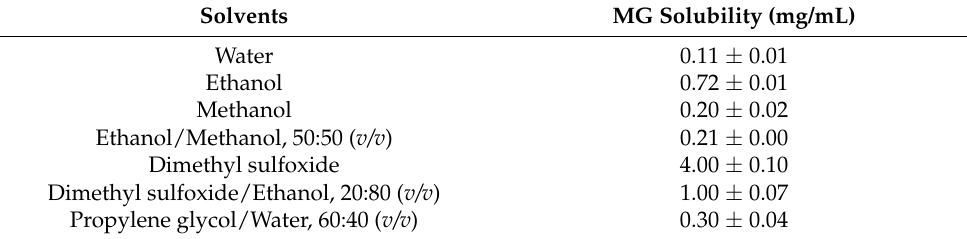
Table 1. Mangiferin solubility in different solvents and solvent mixtures.